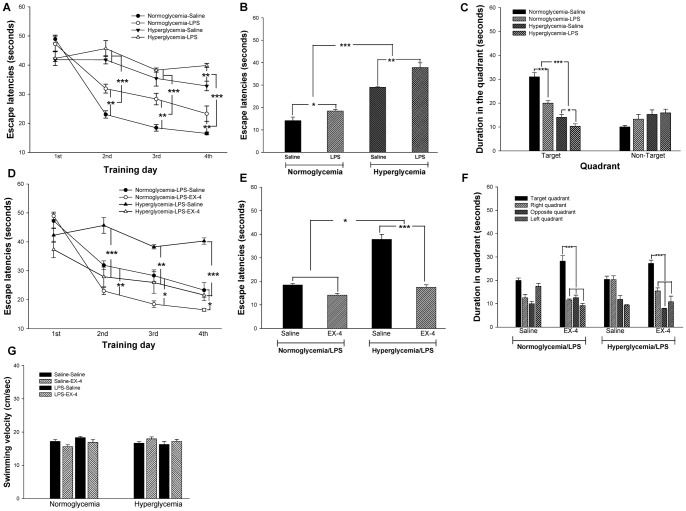
Effects of hyperglycemia, LPS and EX-4 on spatial reference learning and memory.The mouse learning curve is shown in (A). Intrahippocampal LPS injection exacerbated the impairment of spatial learning acquisition (B) and spatial memory retrieval (C) in the hyperglycemic mice. In addition, EX-4 treatment protected against the impairment of spatial learning acquisition (D & E) and spatial memory retrieval (F) following intrahippocampal LPS injection in the normoglycemic or hyperglycemic mice. These results were independent of the swimming velocity (G). Data are expressed as means ± S.E.M. (n = 15–20 per group). * p<0.05; ** p<0.01; *** p<0.001.